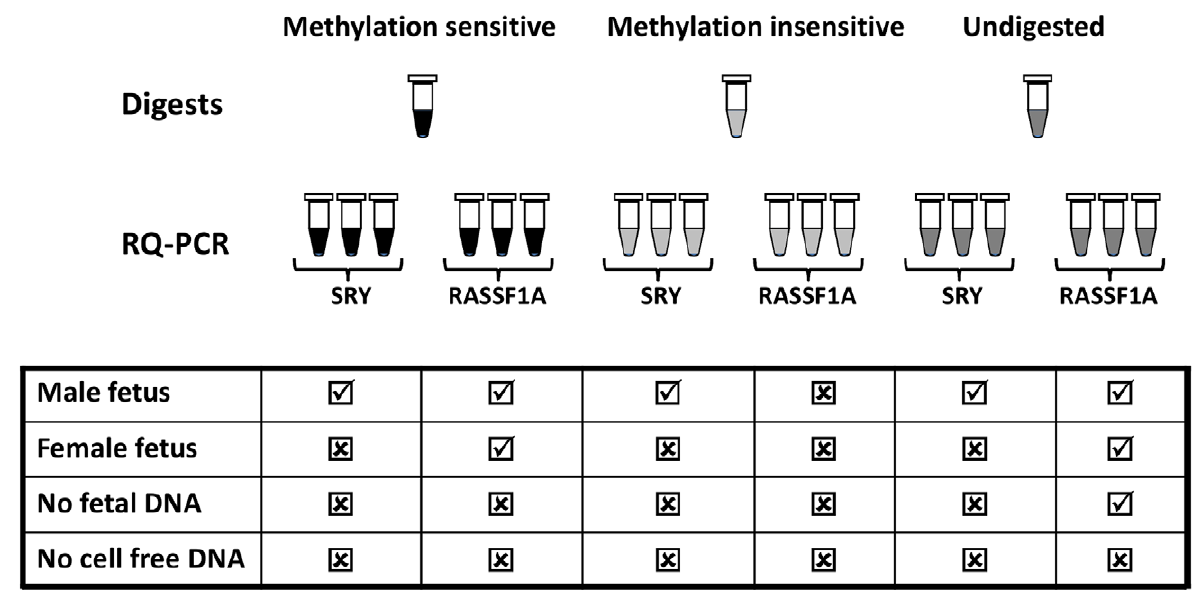
Figure 1. Schematic representation of the possible results obtained using hypermethylated RASSF1A as a universal fetal marker when determining fetal sex by NIPD for a male fetus, female fetus, a case where no cell free fetal DNA is present and a case where no total cell free DNA is present. Ticks represent the presence of amplified products from either the SRY assay or the RASSF1A assay. Crosses represent no amplification of SRY or RASSF1A amplicons.